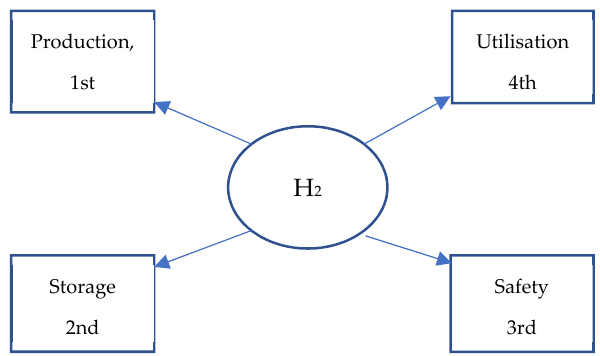
Figure 2. Hydrogen Square (HydS): four corners model. Hydrogen economy seems achievable when a 100% renewable electric grid complied and expanded to a 100% renewable energy supply though the development of all corners of HydS, production from renewable energy resources, and renewable hydrogen (i.e., Green Hydrogen) [61,62]. Green hydrogen has the ability to decarbonise a wide range of economic uses or act as a clean energy carrier for storing renewable energy to be be used in a lot of areas [63]. Nevertheless, for green pathways to become technoeconomically viable, simultaneous growth at the four corners of the HydS is required.